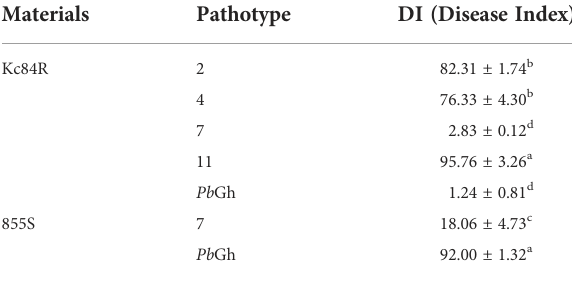
TABLE 1 Disease investigation for susceptibility of parent materials to P. brassicae pathotypes.